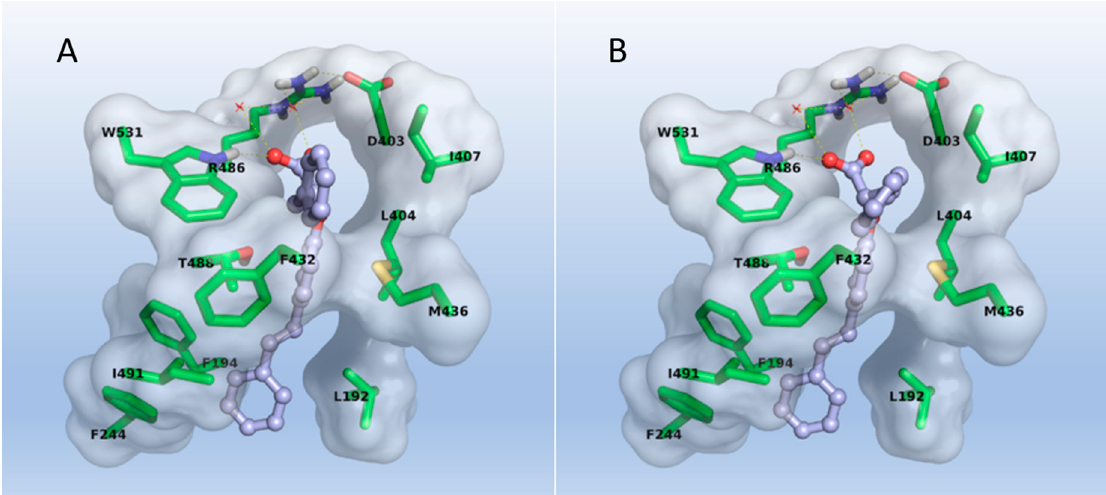
Figure 5. Docking poses of ( R ), ( A ), and ( S ), ( B ) enantiomer of compound 18 into the FAAH binding site.